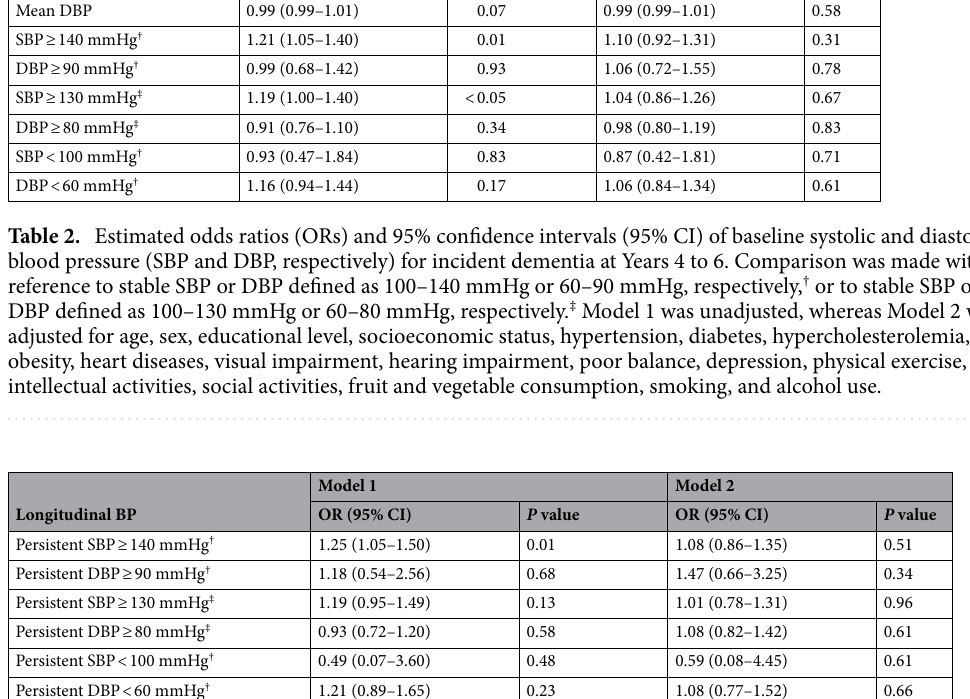
Table 3. Estimated odds ratios (ORs) and 95% confidence intervals (95% CI) of persistent systolic and diastolic hypertension and hypotension from baseline to Year 3 for incident dementia at Years 4 to 6. Comparison was made with reference to stable SBP or DBP defined as 100–140 mmHg or 60–90 mmHg, respectively, † or to stable SBP or DBP defined as 100–130 mmHg or 60–80 mmHg, respectively. ‡ Model 1 was unadjusted, whereas Model 2 was adjusted for age, sex, educational level, socioeconomic status, hypertension, diabetes, hypercholesterolemia, obesity, heart diseases, visual impairment, hearing impairment, poor balance, depression, physical exercise, intellectual activities, social activities, fruit and vegetable consumption, smoking, and alcohol use.